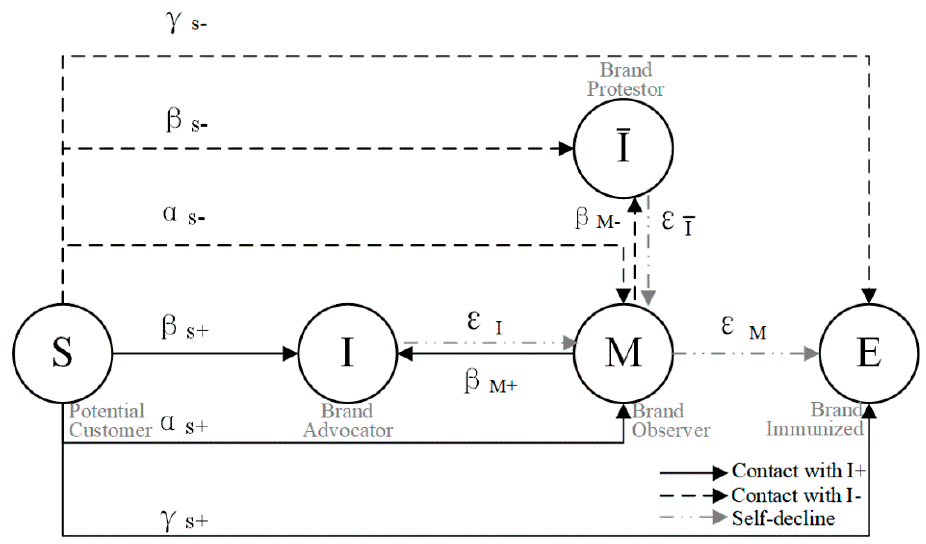
Figure 3. The brand heterogeneous OWOM virus infection model in social media.